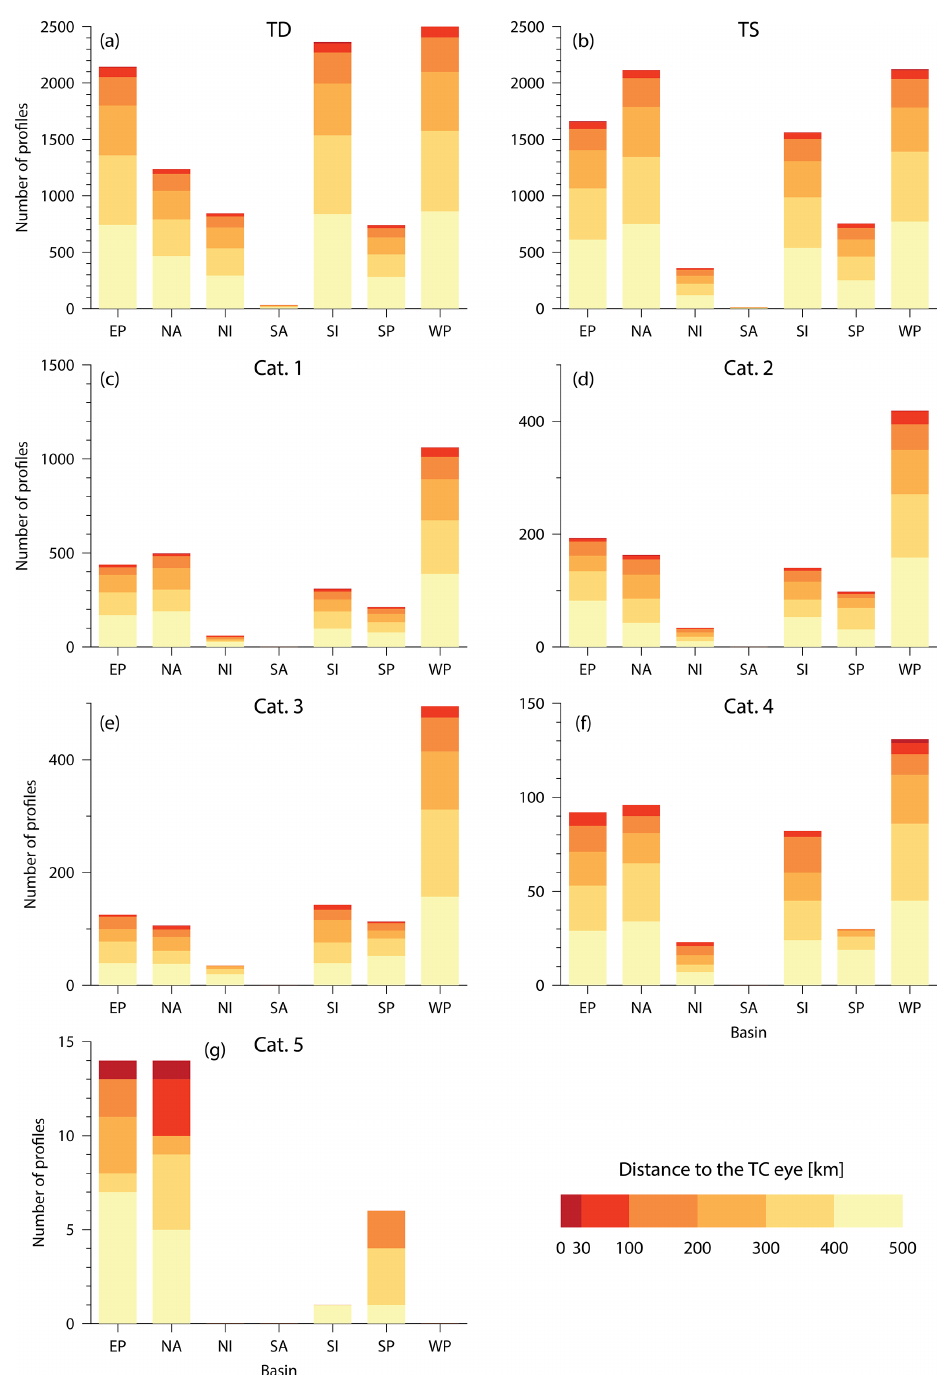
Figure 3. Histograms of collocated RO profiles with (a) tropical depressions, (b) tropical storms, (c) Category 1 TCs, (d) Category 2 TCs, (e) Category 3 TCs, (f) Category 4 TCs and (g) Category 5 TCs for different ocean basins. Colours denote the distances between the RO profile and the TC